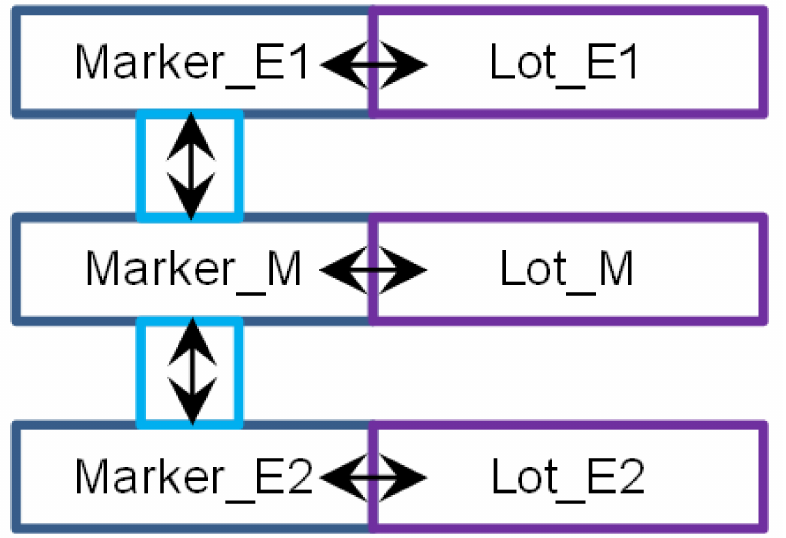
Figure 10. Scheme of road segments (with their markers) and parking lots in an automated vehicle guidance system